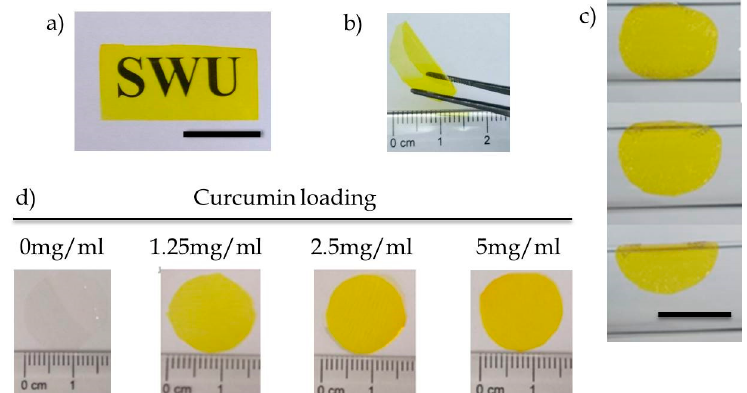
Figure 1. ( a ) Transparency of curcumin-loaded silk fibroin film (the background is white paper printed with the SWU logo, scale bar 10 mm), ( b ) free-standing curcumin-loaded silk fibroin film in the dry state, ( c ) hydrated films follow surface contours (scale bar: 10 mm), and ( d ) silk fibroin films can be loaded with a range of curcumin concentrations.